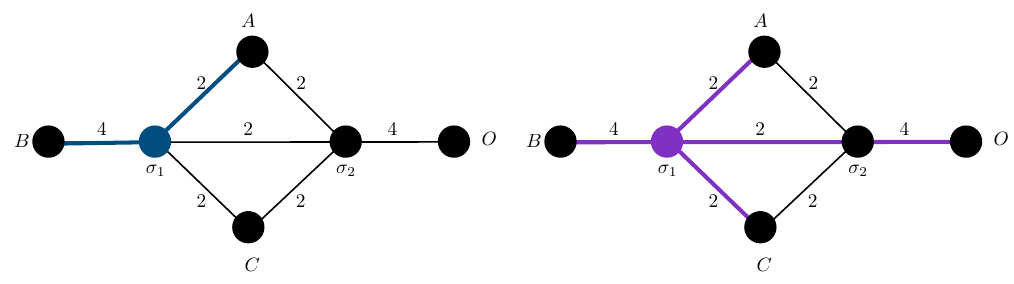
Figure 9 . L: an AB 2-thread. R: an ABCO